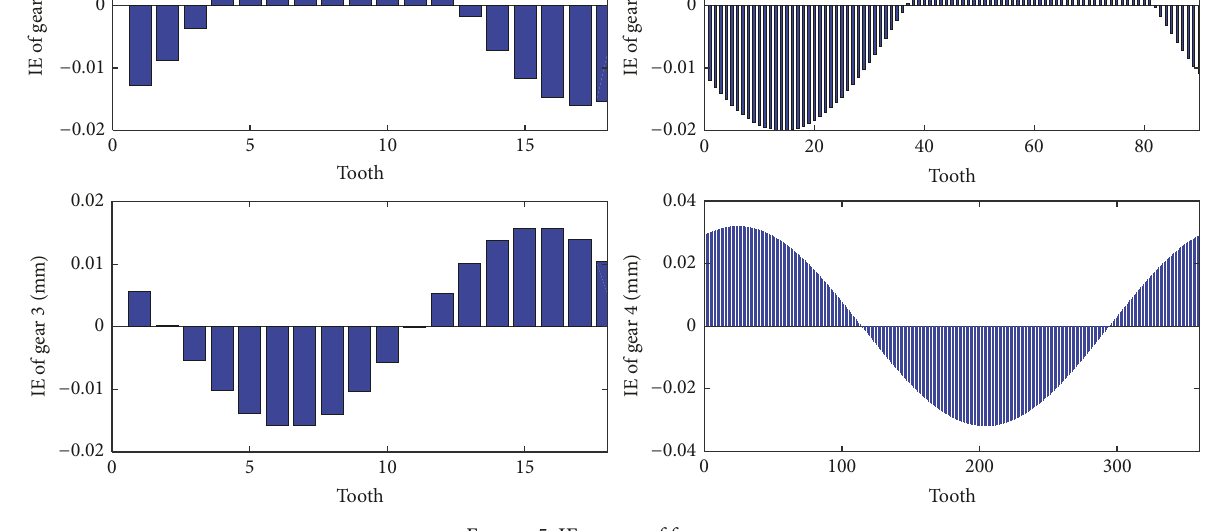
Figure 5: IE curves of four gears.